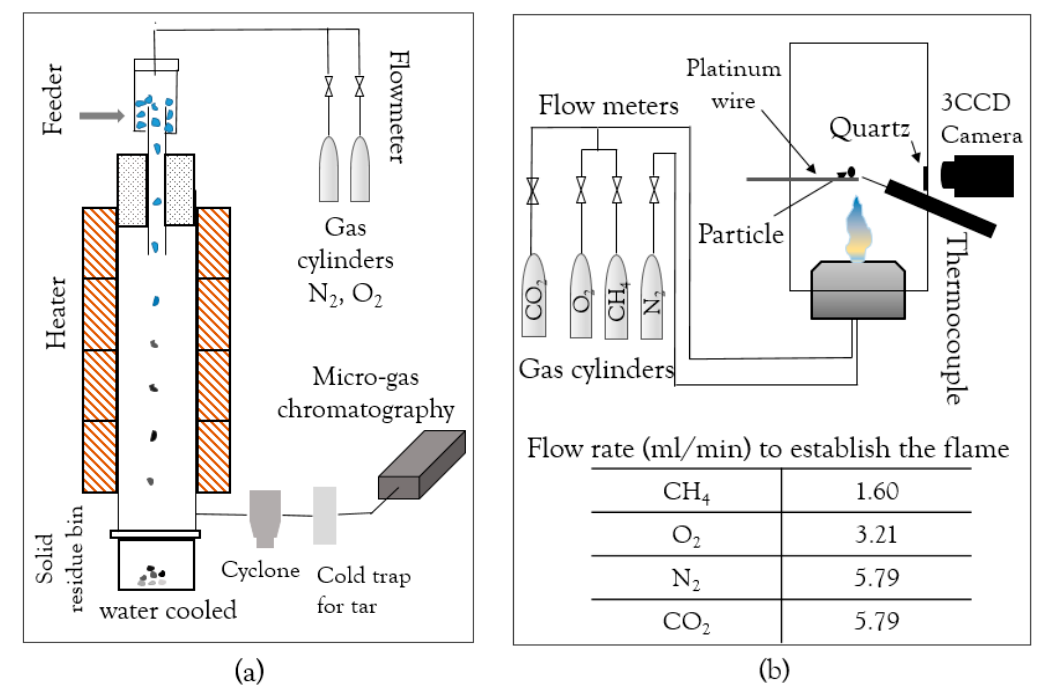
Figure 3. Schematic illustration of ( a ) the laminar drop tube furnace (DTF), adopted from [18], ( b ) schematic of the optical single particle burner adapted from [19].